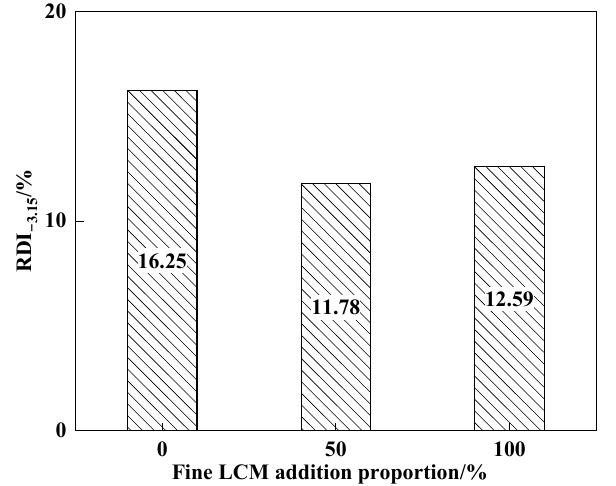
Figure 17. Effects of fine LCM addition on RDI − 3.15 of sinter.